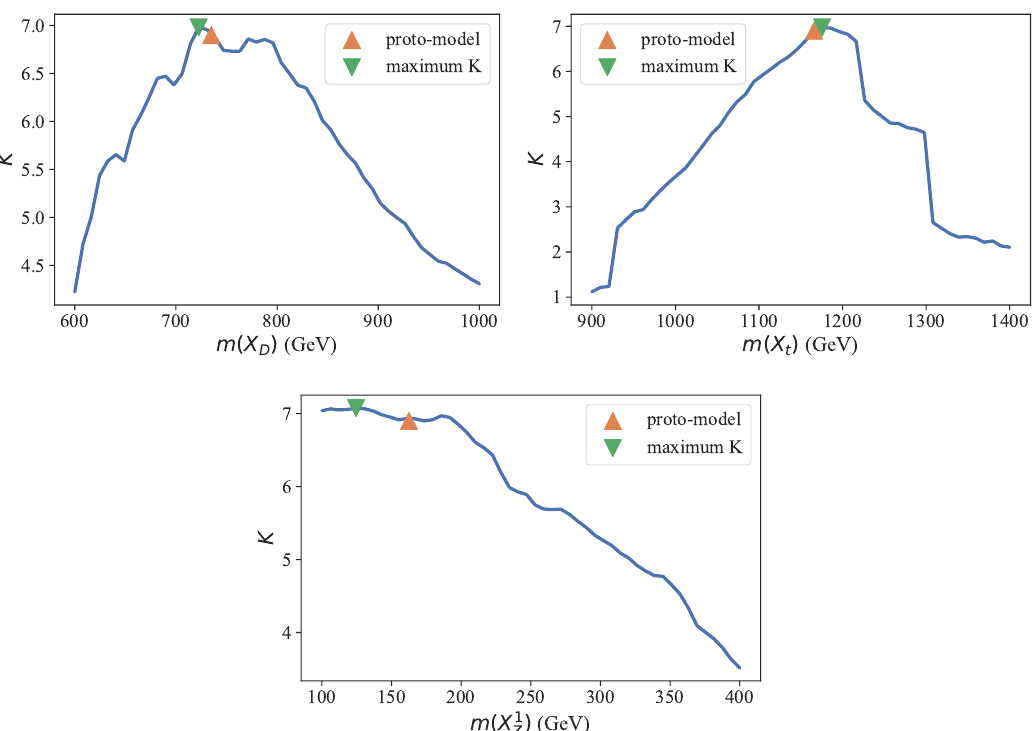
Figure 12 . The test statistic K (blue line) in the vicinity of the highest-score proto-model, run 9 from figure 8, as a function of this proto-model’s masses; on the top left for X . The maximum K in each case is indicated by a green downward X t and on the bottom for X 1 Z triangle, and the K of the highest-score proto-model as an orange upward triangle.